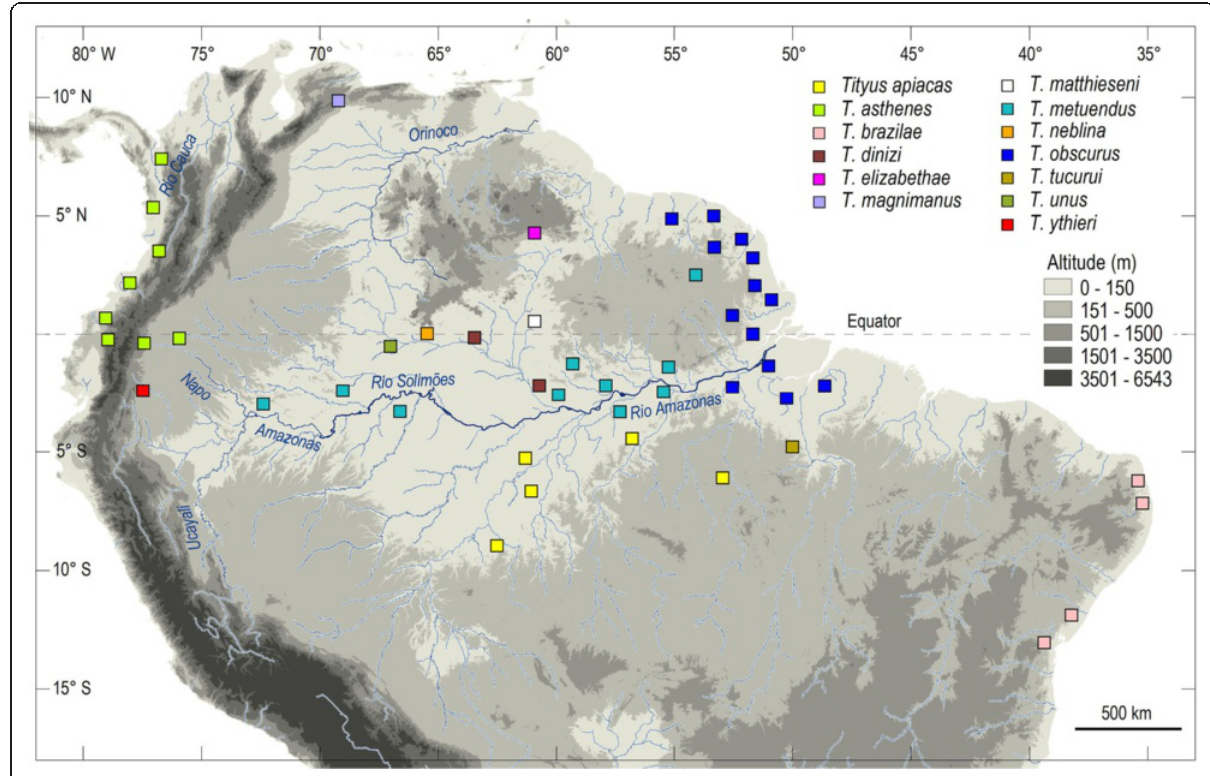
Fig. 25 Map of northern South America – Amazonian and Guayana regions – showing the known distribution of the most important Tityus ( Atreus )